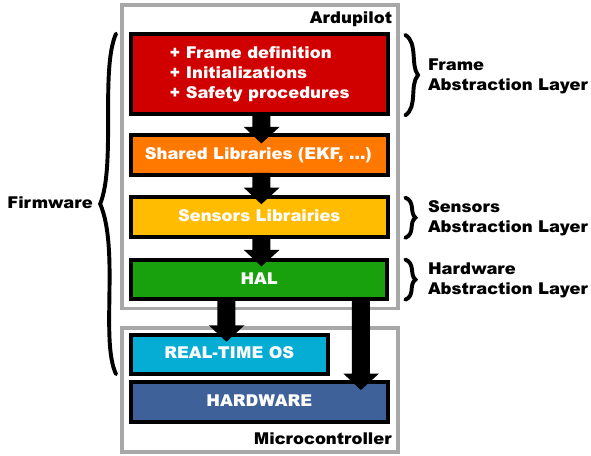
Figure 2. General overview of Ardupilot and its three main layers of